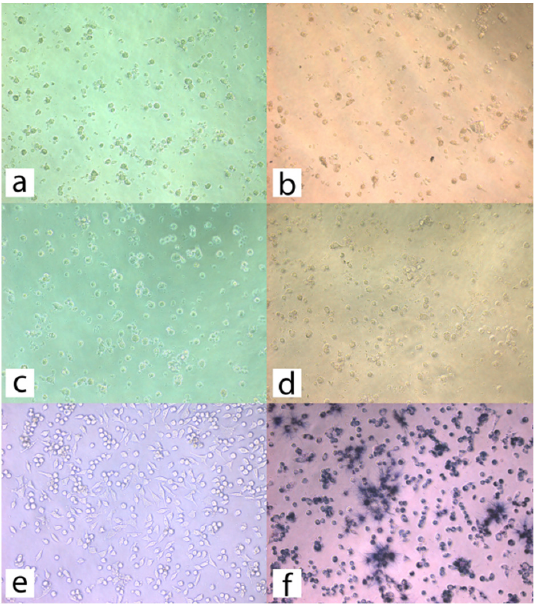
Figure 3. ( a ) L-929 line cells after 24 h incubation with a 2-fold diluted 24 h extract of the experi- mental preparation, ( b ) L-929 line cells after 24 h incubation with a 2-fold diluted 24 h extract of the experimental preparation after MTT assay, ( c ) L-929 cells after 24 h incubation with 2-fold diluted 24 h Icon extract, ( d ) L-929 cells after 24 h incubation with 2-fold diluted 24 h Icon extract after MTT test. ( e ) Control culture of adhered L-929 cells, ( f ) control culture of adhered L-929 cells after MTT test.